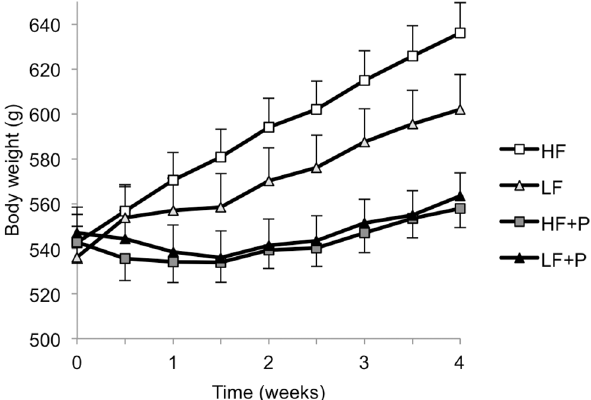
Fig 1. Body weight. Body weights of diet induced obese rats fed high fat diet (HF), high fat diet with 10% w/w pectin (HF+P), low fat diet (LF), or low fat diet with 10% w/w pectin (LF+P) for 4 weeks in two independently replicated experiments ( n = 16 per diet group). ANOVA revealed HF > LF > HF+P, LF+P ( P <